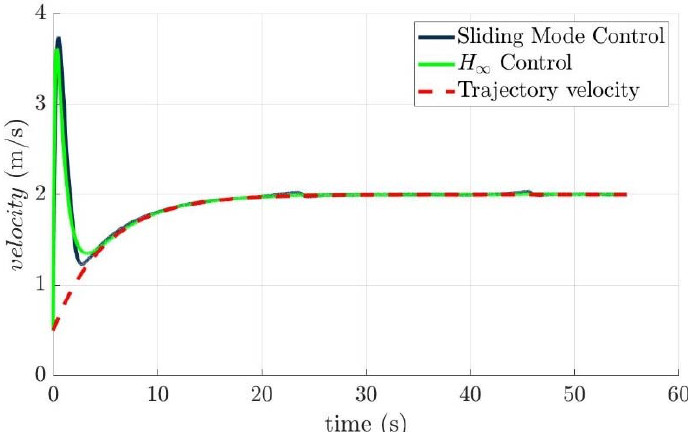
Figure 13. Histories of the attitude tracking errors of the torpedo-like underwater vehicle: ( a ) roll direction, ( b ) pitch direction, and ( c ) yaw direction.